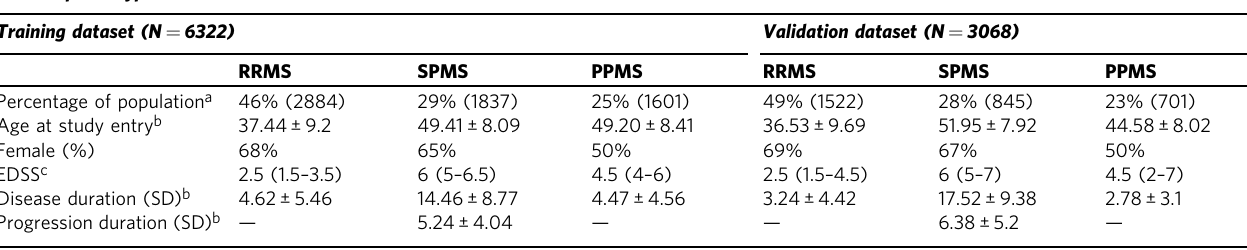
Table 2 Patients ’ characteristics in the training and validation